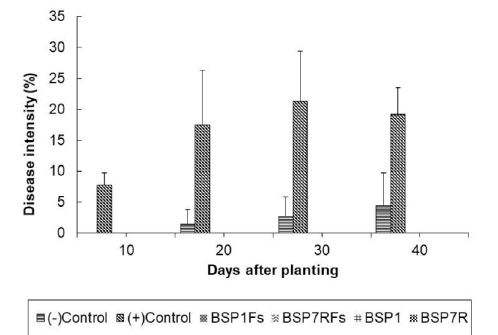
Fig. 4. Profile of disease intensity of Fusarium wilt among treated plants table 3. Bacterial cell number among treatments before and after application Treatments Number of cell densities (CFU.g -1 ) Before